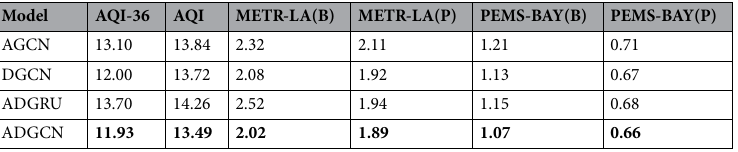
Table 5. Ablation experiments, MAE values for an average of 5 times, (P) and (B) indicate missing points and blocks missing settings respectively. The best results are in